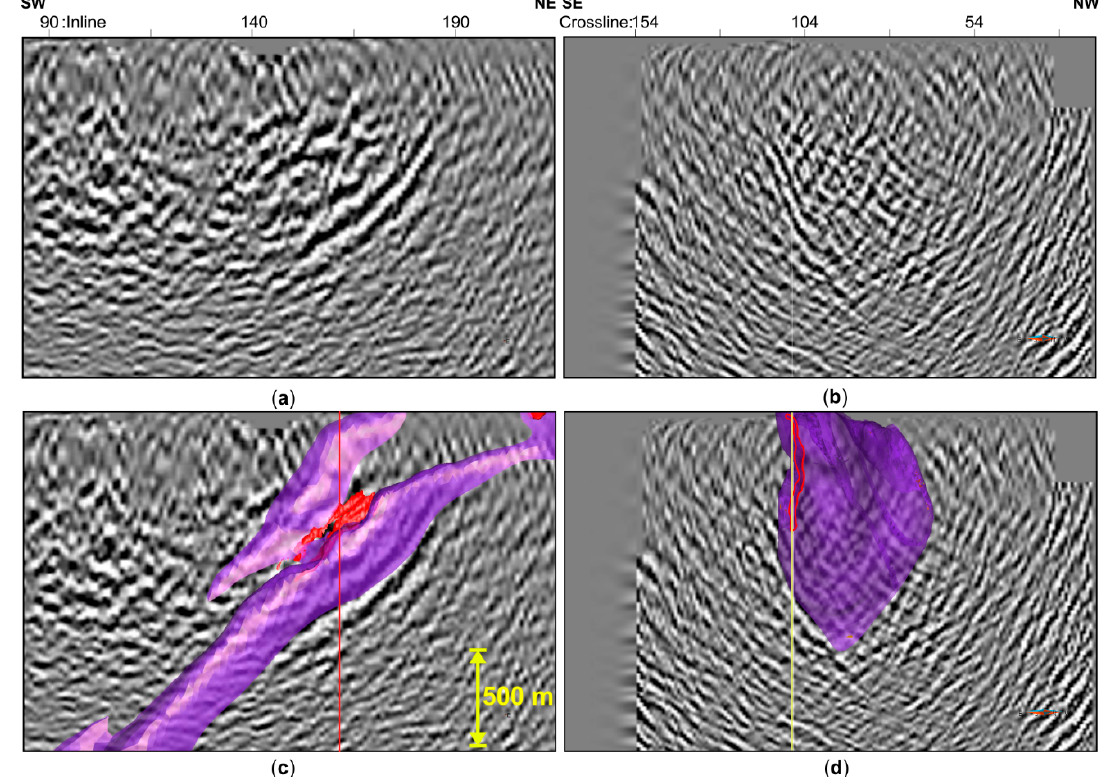
Figure 10. Crossline ( a ) and inline ( b ) extracted from the KPreSDM; ( c ) and ( d ) shows the data overlaid with the modelled base (from the borehole data) of the Kylylahti formation (in violet) and Kylylahti ore bodies (in red). See Figure 1 for location of the sections. The red line in (c) shows the inline position and yellow line in (d) shows the corresponding crossline position.